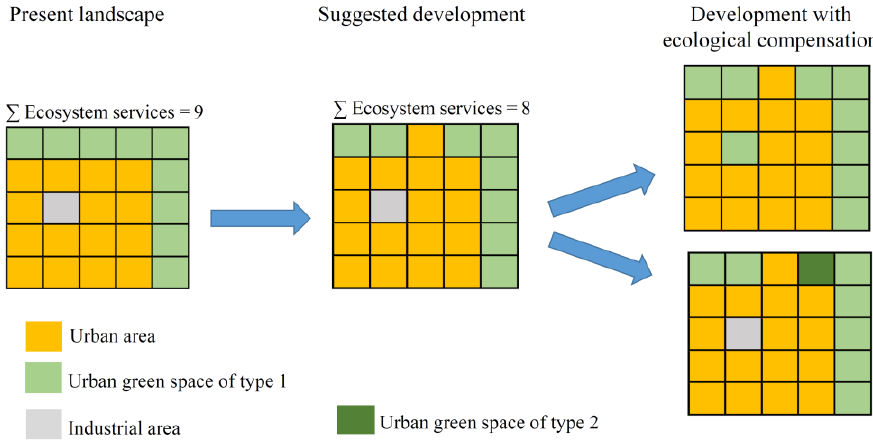
Figure 1. Utilization of a recreation area with compensation in different areas.